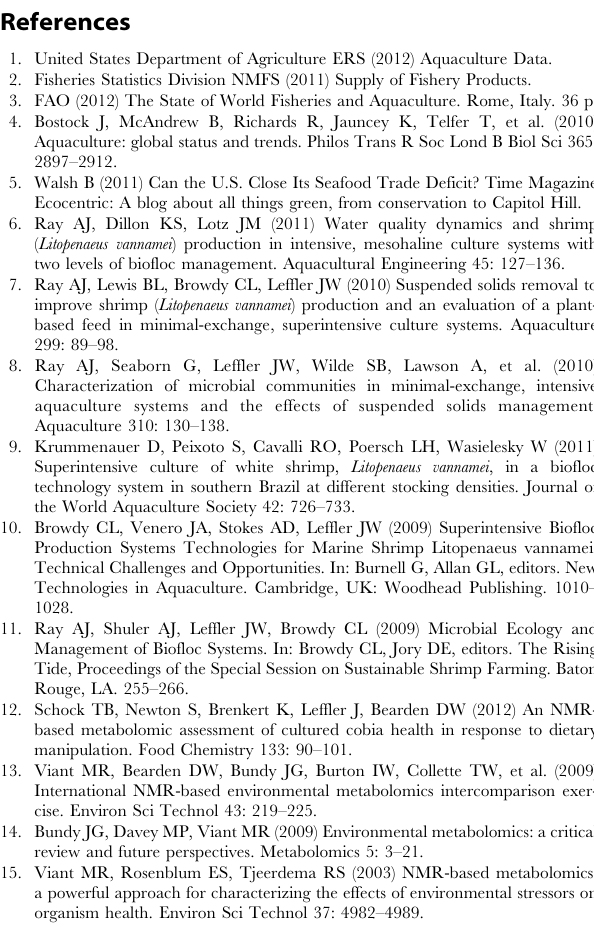
Table S2 Identified shrimp metabolites. Compound list of